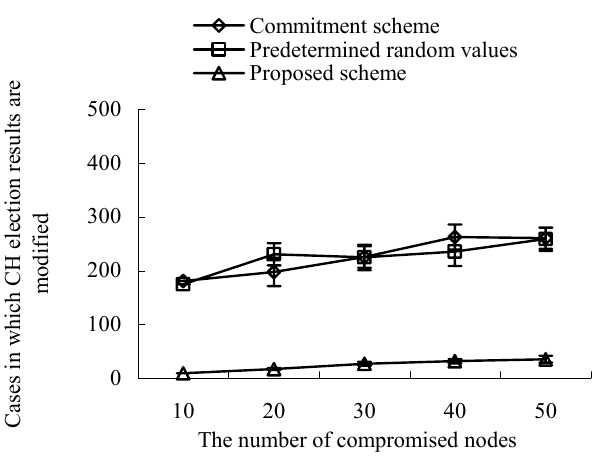
Figure 7. Cases in which CH election results are modified vs. compromised